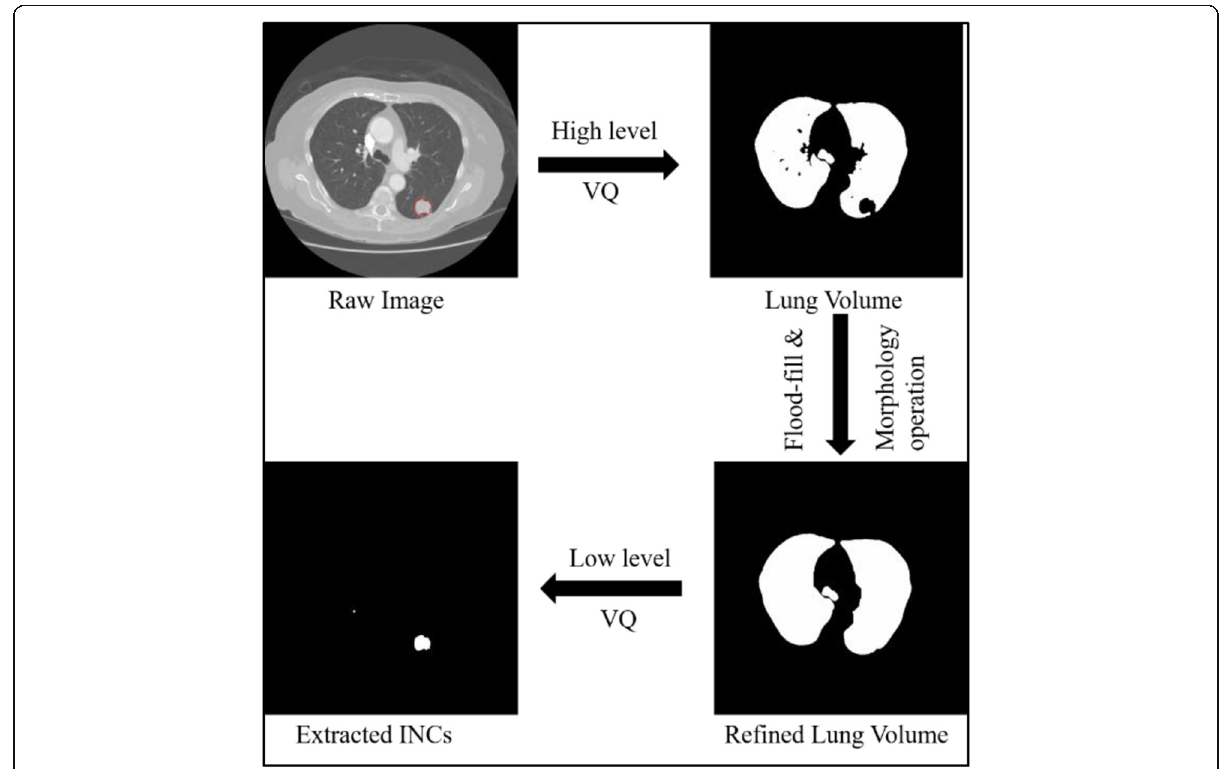
Fig. 1 Examples of the initial nodule candidates